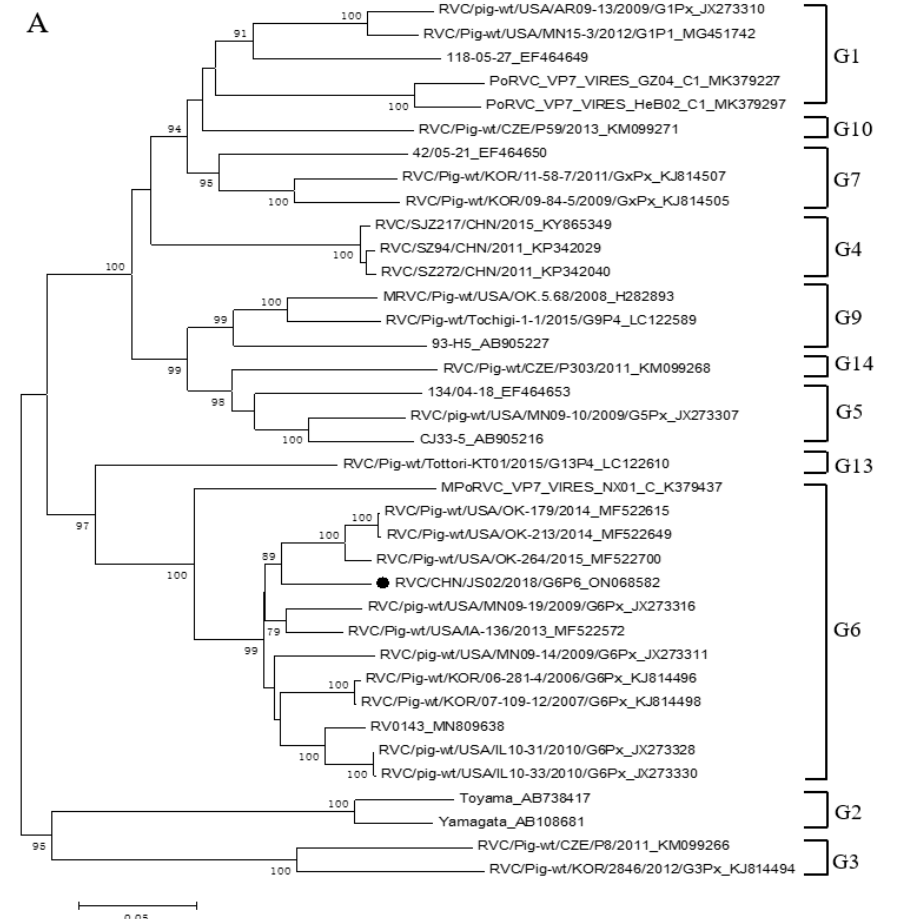
VP7 gene contained 1011 nucleotides (nt), encoding 336 amino acids (aa). A phylogenetic tree was constructed using RVC/Pig/CHN/JS02/2018/G6P6 VP7 gene with sequence selected G genotypes in GenBank. The results in Table 1 show that the VP7 gene of RVC/Pig/CHN/JS02/2018/G6P6 was most closely related to RVC/Pig-wt/USA/OK- 264/2015 (MF522700) which was isolated from USA at 92.4% and belonged to G6 geno- type in Figure 2A. The VP4 gene contained 2208 nt, encoding 735 aa. The VP4 gene of RVC/Pig/CHN/JS02/2018/G6P6 was most closely related to RVC/Pig-wt/KOR/2885/2012/ G7PX (KJ814475) isolated from South Korea at 88.5% and belonged to P6 genotype as in Figure 2B. The VP6 gene of RVC/Pig/CHN/JS02/2018/G6P6 was most closely related to RVC/Pig-wt/USA/CO76/2012/G6P5 (MG451721) isolated from USA at 93.2% and both belonged to the I5 genotype as seen in Figure S2A. The VP1 gene of RVC/Pig/CHN/JS02/ 2018/G6P6 was most closely related to PoRVC_VP1_VIRES_HeB02_C2 (MK379289) iso- lated from China at 95.7% and belonged to the R1 genotype as in Figure S2B. The VP2 gene of RVC/Pig/CHN/JS02/2018/G6P6 was most closely related to CJ59-32 (LC307108) isolated from Japan at 90.6% and belonged to the C1 genotype (Figure S2C). The VP3 gene of RVC/Pig/CHN/JS02/2018/G6P6 was most closely related to RVC/Pig-wt/Ishi- 1/2015/G13P4 (LC122626) isolated from Japan at 97.3%% and belonged to the M3 genotype, as seen in Figure S2D.